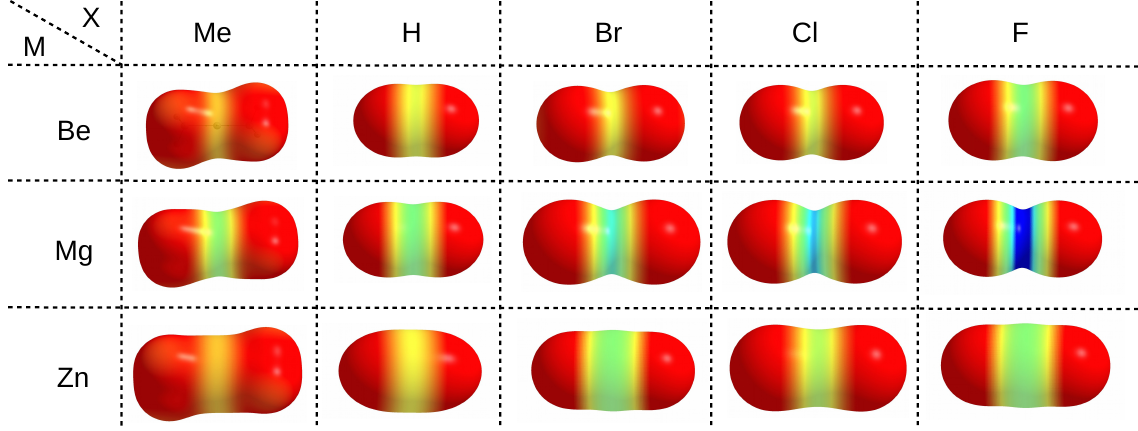
Figure 3. Maps of electrostatic potential projected on 0.001 au isodensity surfaces of MX 2 (M = Be, Mg, Zn; X = Me, H, F, Cl, Br). A common value scale (in au) was used: 0.0—red, 0.05—yellow, 0.1—green, 0.15—cyan,